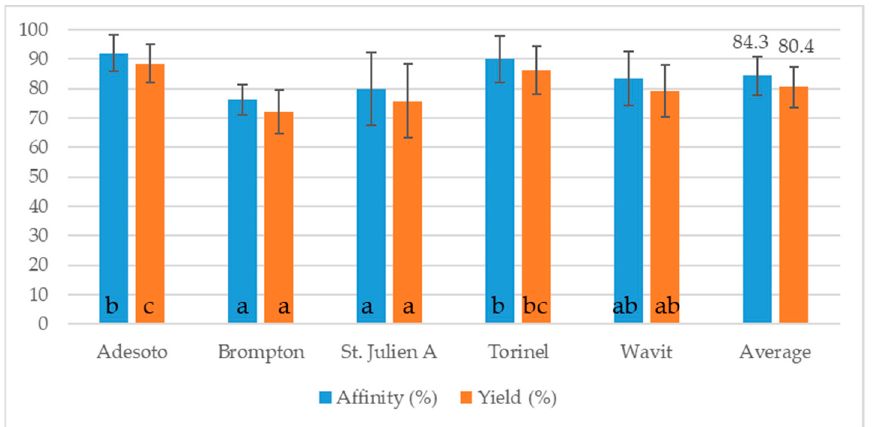
Figure 1. A comparison of the average affinity and yield of saplings, by rootstock. Scale bars refer ± standard deviations. Letters refer to statistical grouping according to the Tukey HSD test. Small letters indicate statistically different homogeneous subgroups.